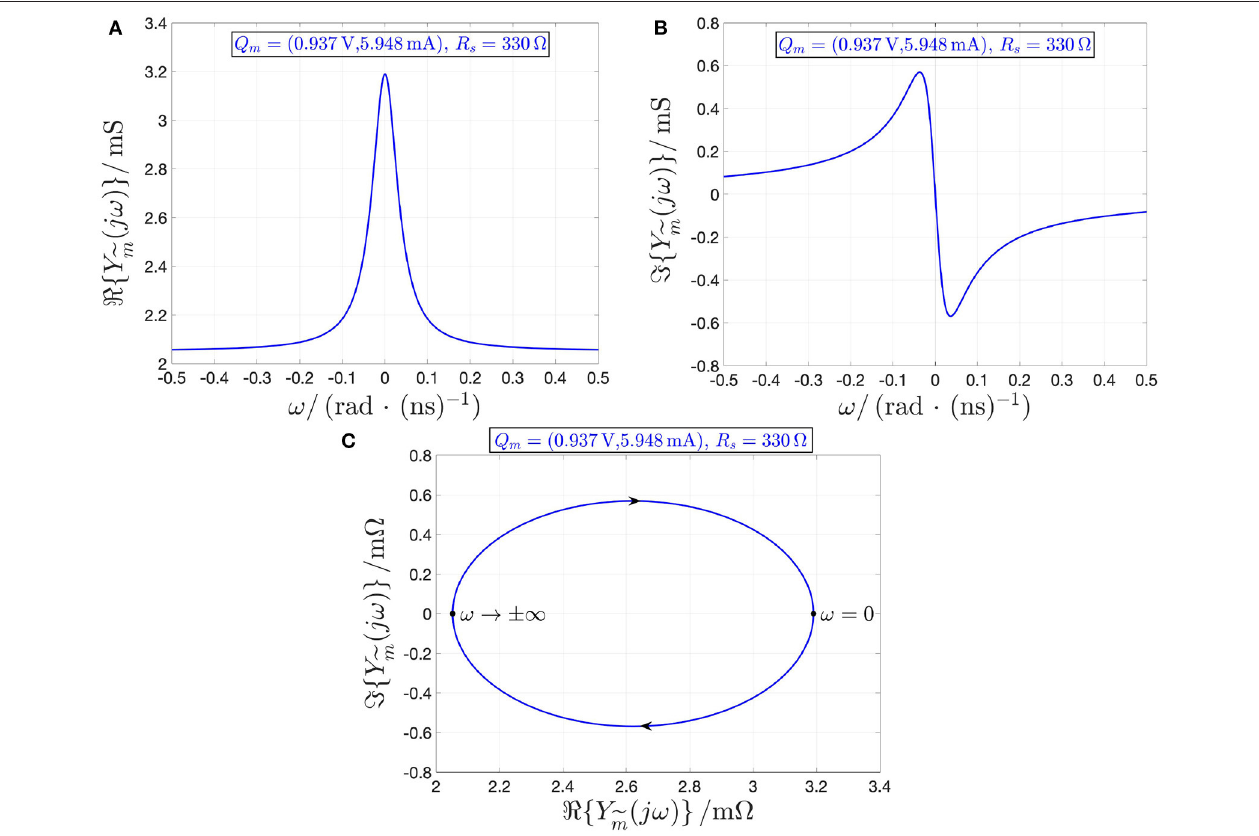
( j ω ) of the combined memristor vs. the angular frequency ω at the operating point ˜ m Y Y ( j ω ) , as computed from (A,B) , with arrows showing how the trajectory point ( j ω )) vs. } } ℜ{ ℑ{ ˜ m ˜ m to . The real part of the combined device local admittance is positive for all angular frequencies. Under −∞ +∞